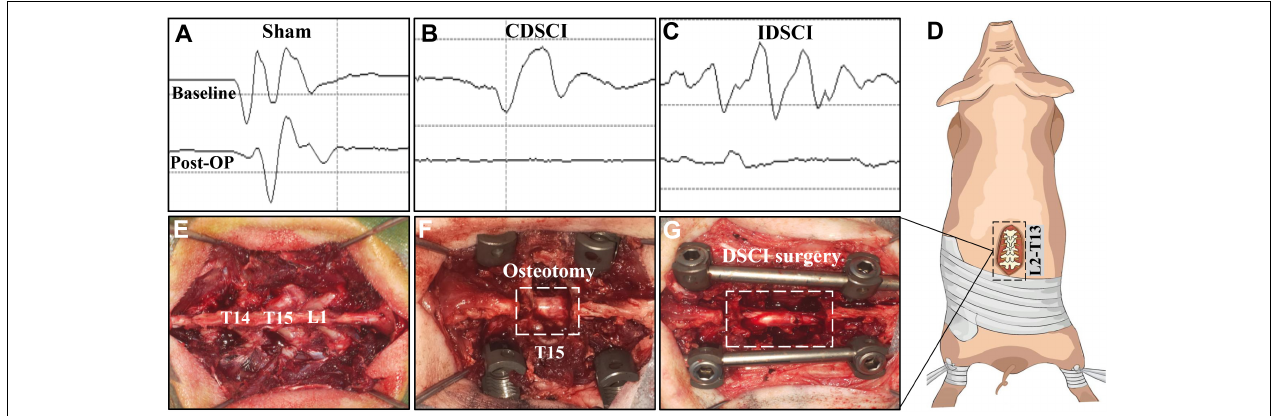
FIGURE 1 | The surgical procedure of the DSCI model establishment and the intraoperative MEP changes in different groups. (A–C) Typical MEP amplitude changes of the pigs in the sham, CDSCI, and IDSCI groups were shown. (D) The intraoperative incision was T13-L2. (E) T14, T15, and L1 laminae were exposed using coagulation cautery. (F) The pedicle screws were inserted in T14 and L1, and the T15 vertebral body and adjacent intervertebral discs were completely resected. (G) The DSCI porcine models were successfully established by gradually increasing the interval between the T14 and L1 using a spinal spreader.